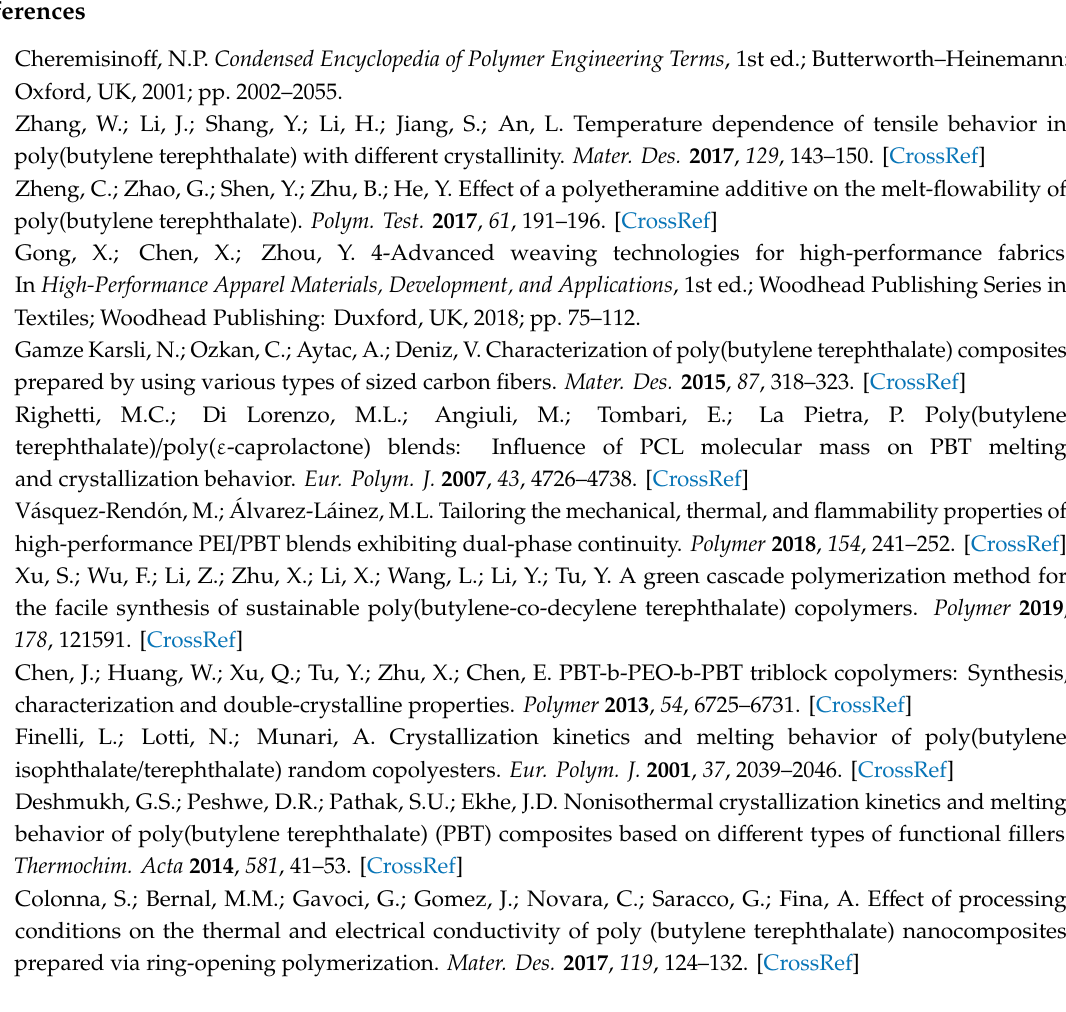
Figure S1: Characterisation of graphene oxide and reduced graphene oxide; Figure S2: SEM images of the surface of PBT + 0.5rGO fibers formed at di ff erent take-up velocities; Figure S3: SEM images of the cross-sections of PBT + 0.5rGO fibers formed at di ff erent take-up velocities; FigureS4: Diameter distribution of PBT + 0.5rGO fibers with di ff erent contents of reduced graphene oxide; Figure S5: Diameter distribution of PBT + 0.5rGO fibers formed at di ff erent take-up velocities; Figure S6: WAXS patterns of PBT + 1.5rGO fibers spun at di ff erent take-up velocities; Figure S7: Deconvolution of the WAXS pattern of the PBT-V600 sample; Table S1: Degree of crystallinity obtained by means of the WAXS method; Table S2: Dimensions of crystallite D hkl in the direction perpendicular to the lattice planes (hkl) determined by means of the WAXS method; Table S3: Results of the SAXS measurement containing a long period L, crystalline l C, and amorphous l A layer